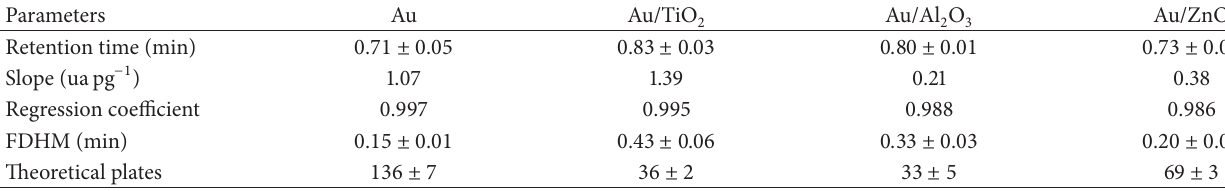
Table 2: Analytical parameters of study